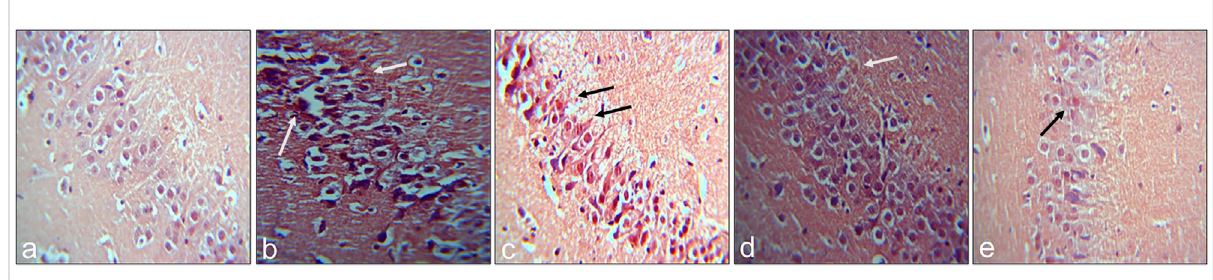
FIGURE 5 Congo red-stained sections of hippocampus for visualization of amyloid plaques: (A) Control (B) A β 1 – 42 -treated group (C) A β 1 – 42 + donepezil- treated group (D) A β 1 – 42 + RA-treated group (E) A β 1 – 42 + UA-treated group. Original Magni fi cation 40X.